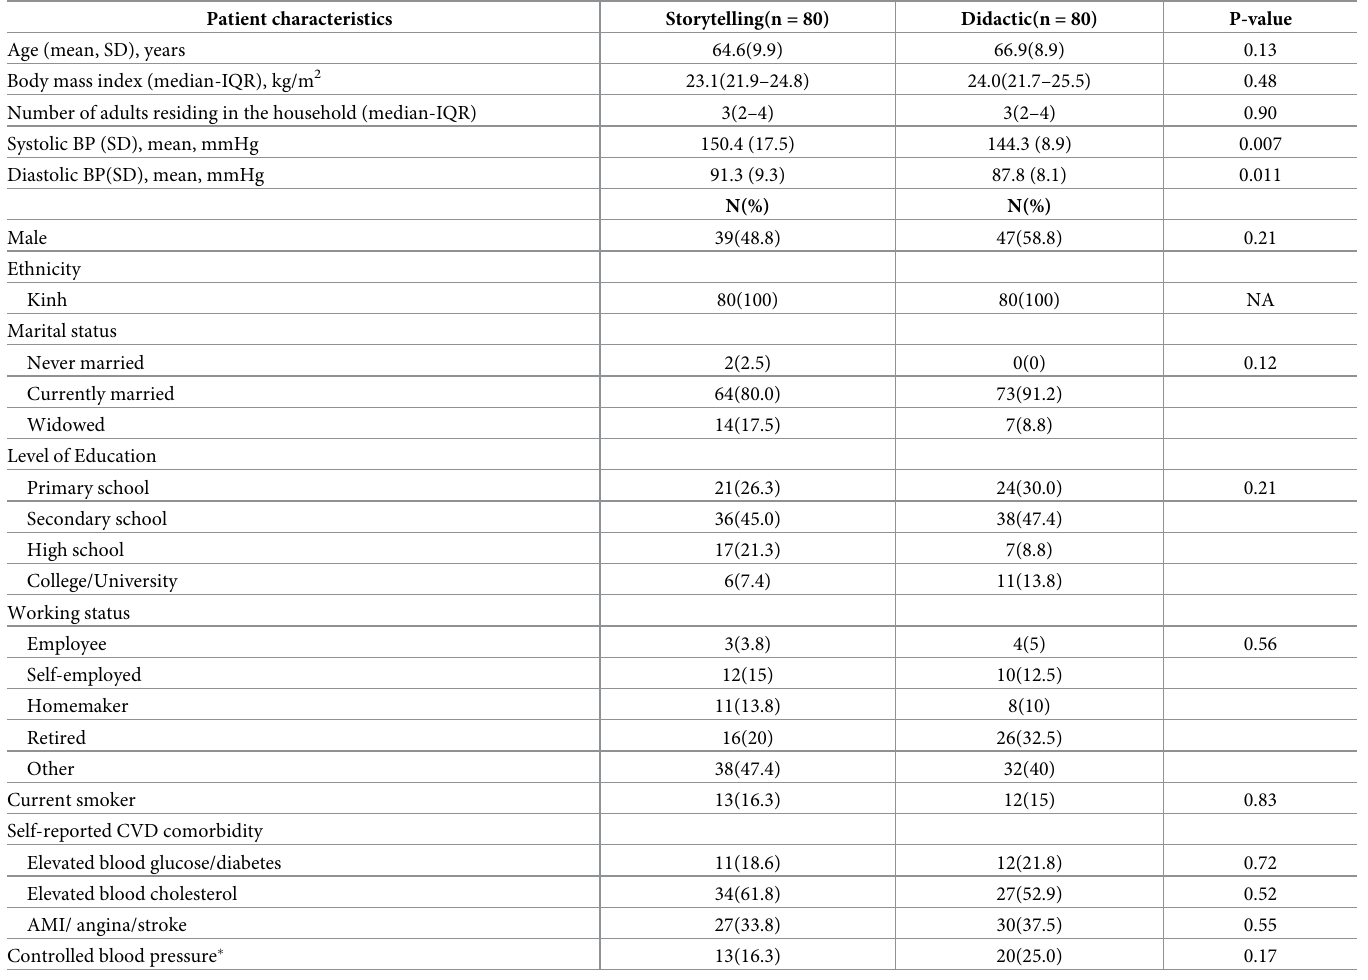
Table 1. Patient characteristics at the time of trial enrollment according to intervention